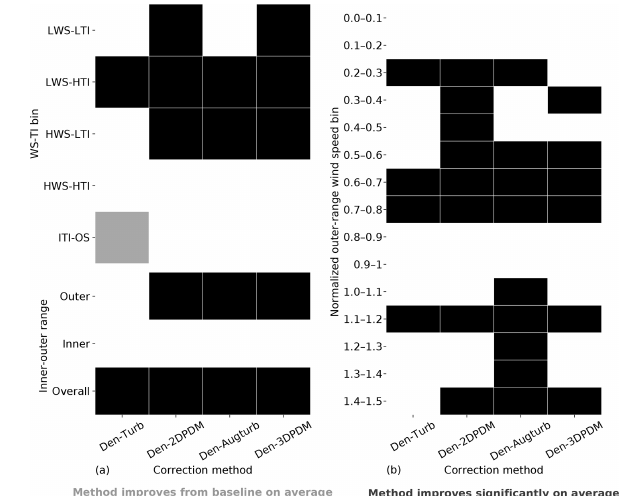
Figure 13. Heat maps of the matched-pair t -test results using the means of the 10000 bootstrapped samples. Passing the t test indi- cates that the average of the 10000 absolute NME means of a trial method is significantly smaller than that of the baseline. The heat maps are categorized into the four WS-TI bins, the ITI-OS bin in the outer range as well as the inner and outer ranges (a) , and normalized wind speed bins in the outer range (b) . The bootstrapping only uses submissions without extreme improvements (Appendix C2). When a trial method demonstrates average improvement and a statistically significant average improvement from the baseline, the inflow con- dition is labeled in grey and black,